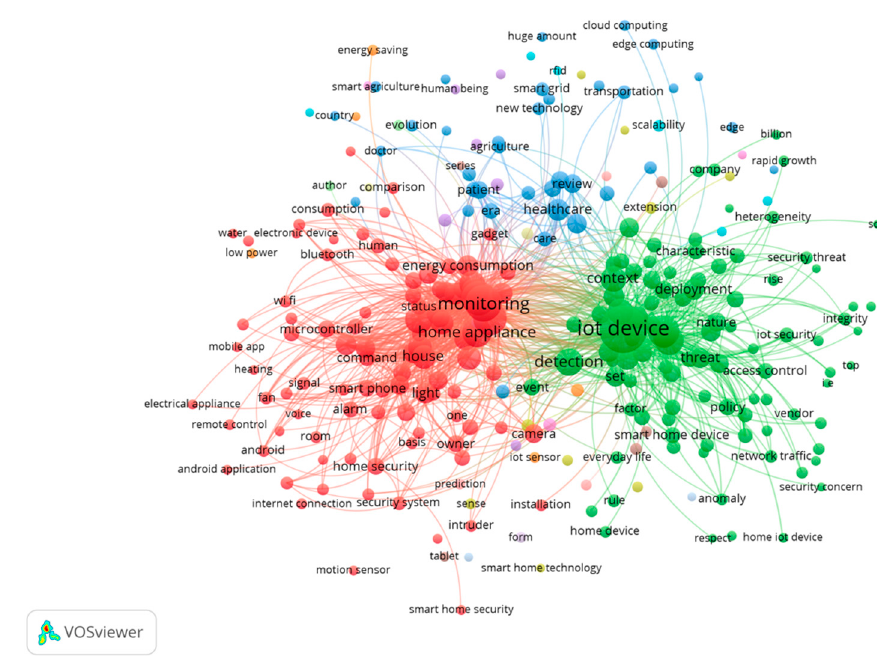
Figure 11. Themes network for 2018.